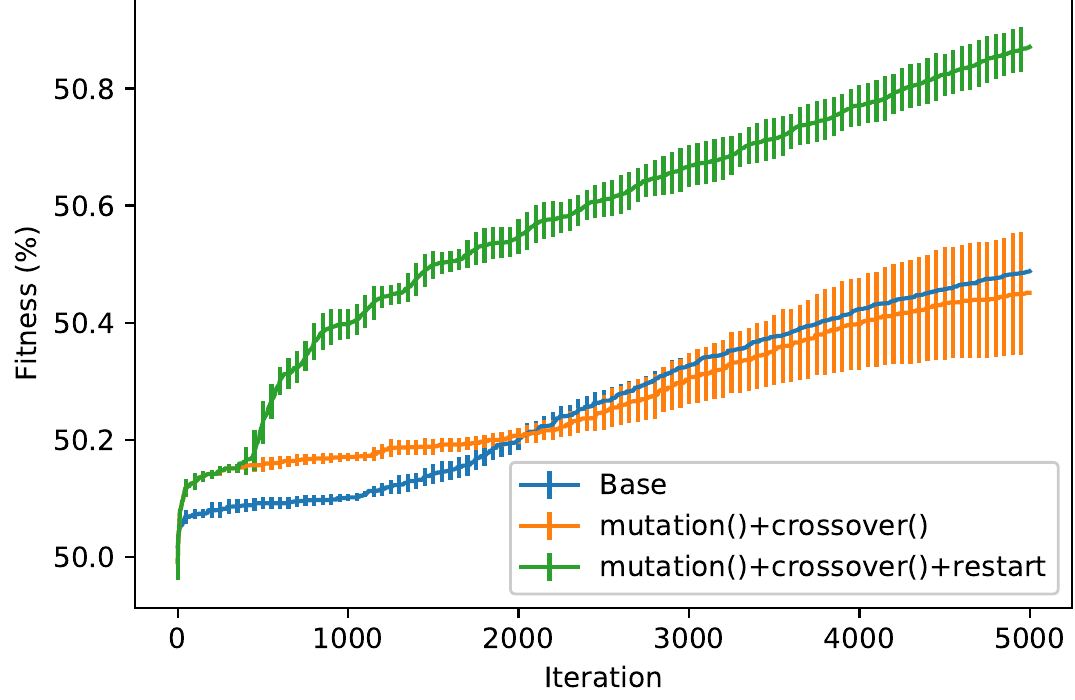
Figure A3. Best fitness value (mean ± std. dev. across 10 runs) for the cGA with different configurations on the continuous OneMax problem in 1M